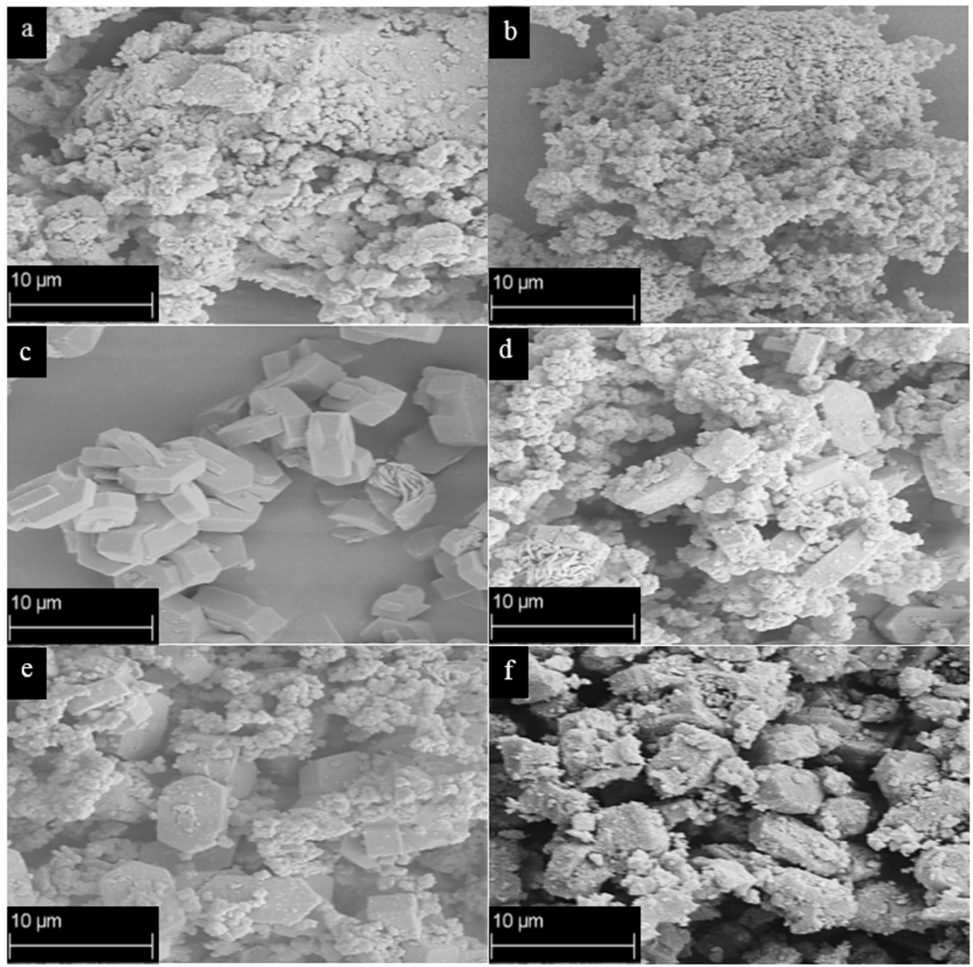
Figure 3. SEM images of ( a ) TiO 2 from sol-gel synthesis; ( b ) Hombikat; ( c ) zeolite ZSM-5; ( d ) composite HZMM (50/50); ( e ) composite HZSSD (50/50); and ( f ) composite TZSG (50/50).